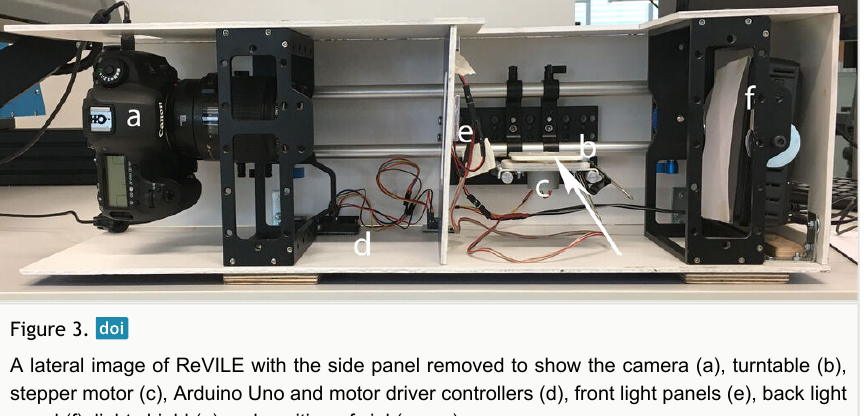
panel (f), light shield (g) and position of vial